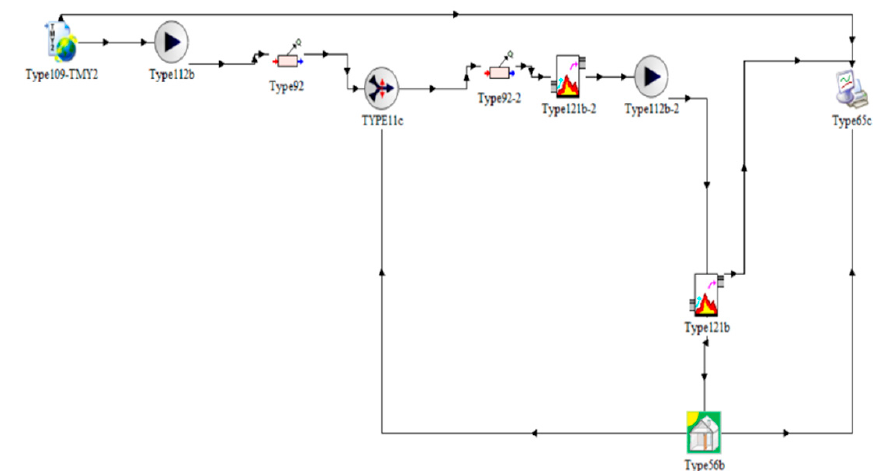
Figure 7. TRNSYS layout for option A.